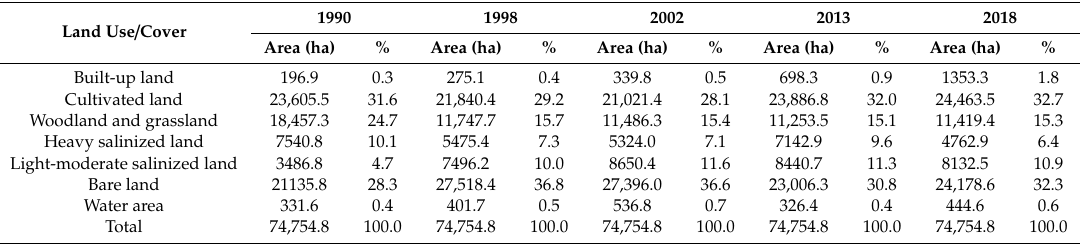
Table 2. Area of LULC classes for the periods in 1990, 1998, 2002, 2013 and 2018 in plain area of Aketao County, China.